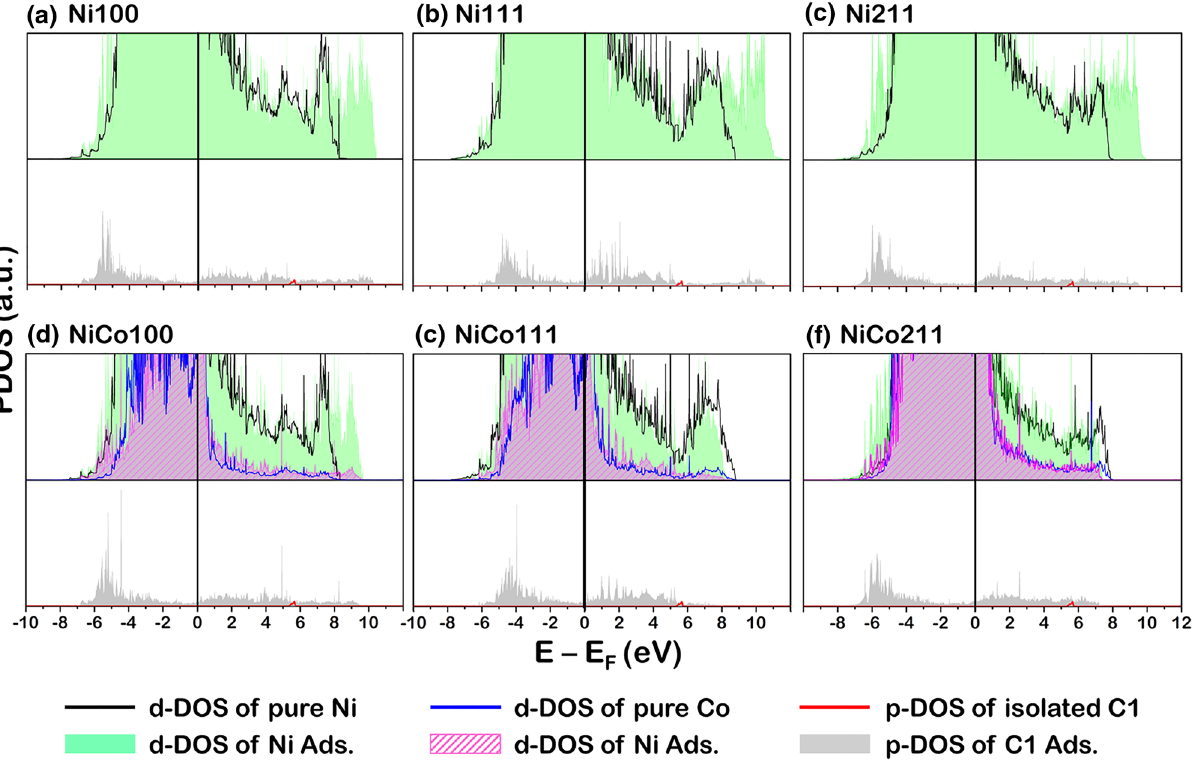
Figure 9. The PDOS profiles of fresh and 1-atom-carbon (C1)—adsorbed catalyst surface: ( a ) Ni100, ( b ) Ni111, ( c ) Ni211, ( d ) NiCo100, ( e ) NiCo111, and ( f ) NiCo211 surfaces. The top panel is the PDOS of the fresh and coked surface, while the bottom panel is the isolated and adsorbed C1